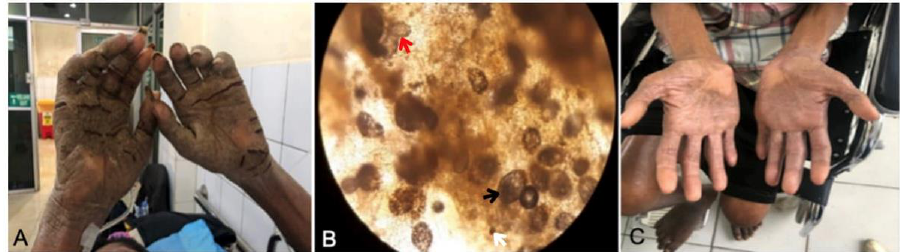
Figure 3. Patient of Case 2 showing gray-brown, slightly yellowish crusts on the both palmar regions ( A ); mineral oil scraping showing Sarcoptes scabiei mite (black arrow), eggs (red arrow), and feces (white arrow) ( B ); and clinical recovery after three weeks of therapy ( C ).